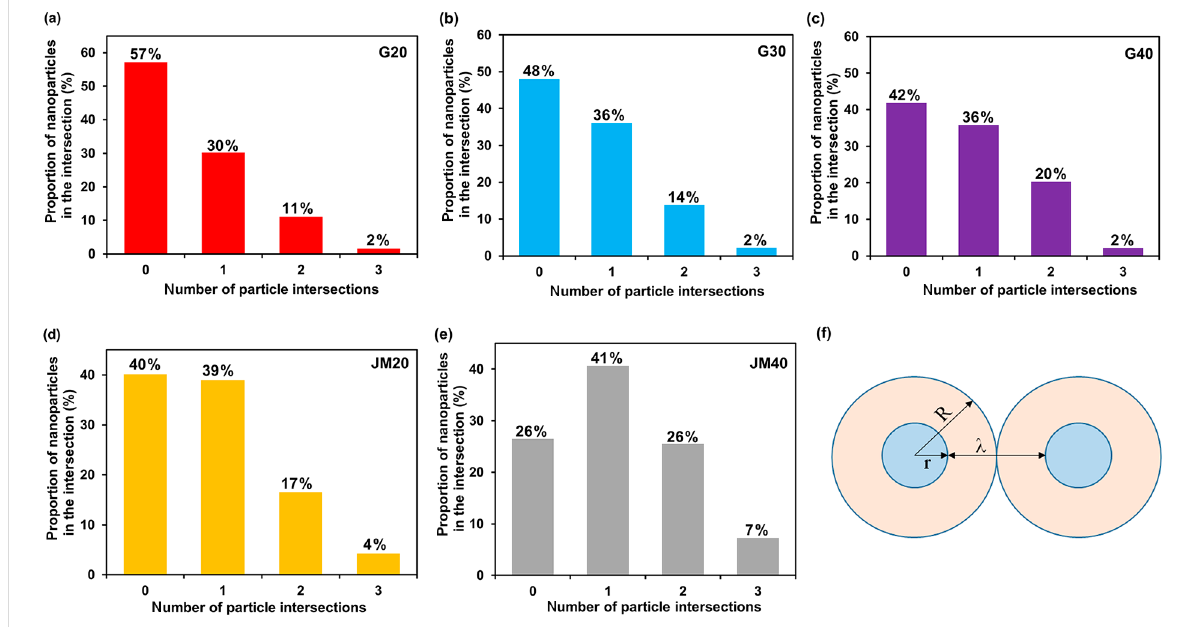
Figure 3: Histograms of nanoparticle distribution by the number of intersections with "neighbors" (a–e) and a schematic representation of the location of spherical nanoparticles within the geometric model (f).